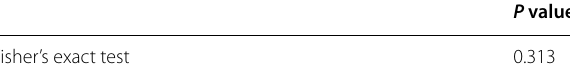
Table 4 Chi‑square tests correlation between the T2 signal intensity of the ablated zone and the residual tumor activity/ recurrent neoplastic viability via statistical analytic